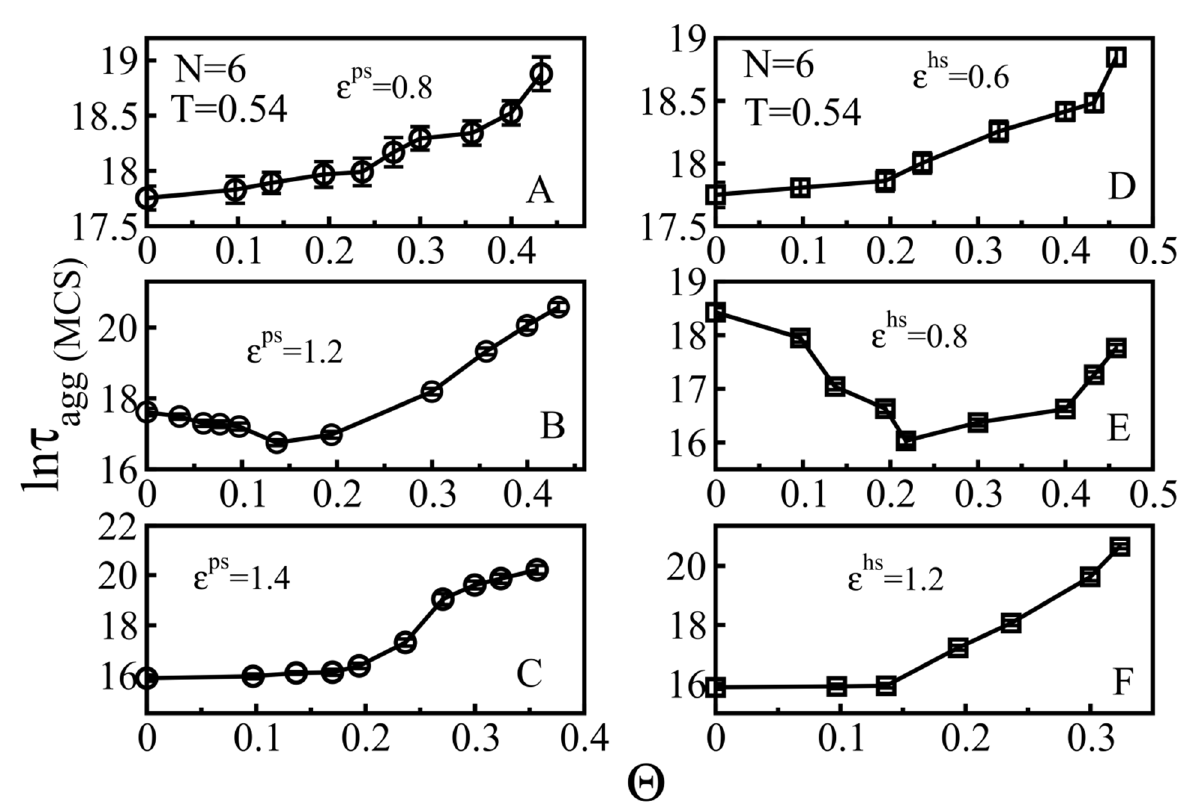
Figure 5. Impact of S-surface roughness on the aggregation of N = 6 peptides at temperature T = 0.54. All graphs on the left column (circular data points) display the dependence of the aggregation time ln τ agg on the rough degree of different hydrophilic surfaces at various values of ε ps = 0.8 ( A ), ε ps = 1.2 ( C ) and ε ps = 1.4 ( E ). Similarly, the dependence of τ agg on Θ S for various hydrophobic surfaces is shown on the right graphs (square data points), ε hs = 0.6 ( B ), ε hs = 0.8 ( D ), and ε hs = 1.2 ( F ).